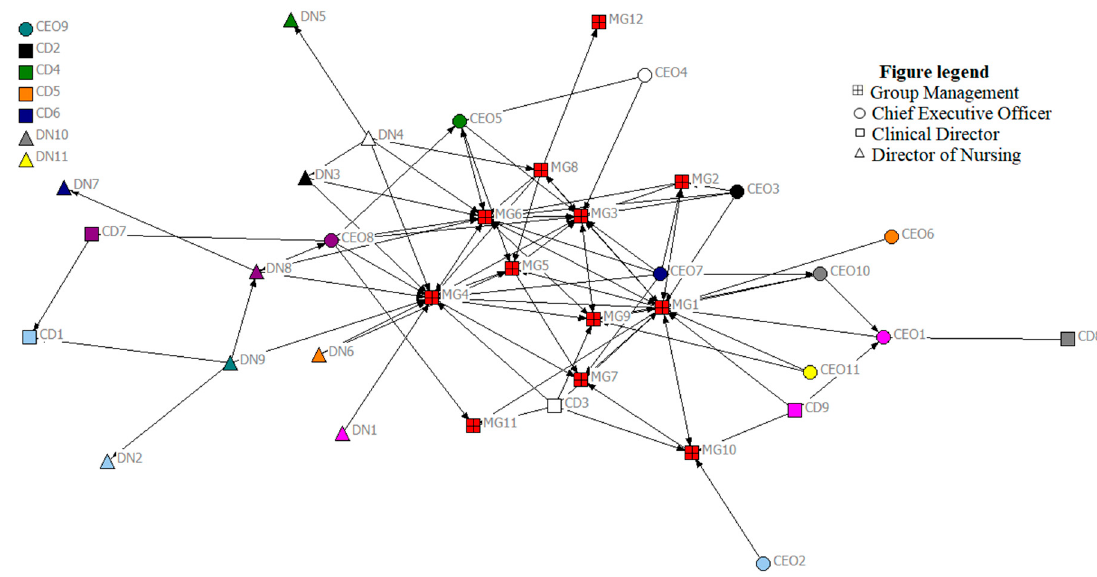
Figure 1. Support relationships across the network—time point 1 (nodes at top left are those with no reported network ties).